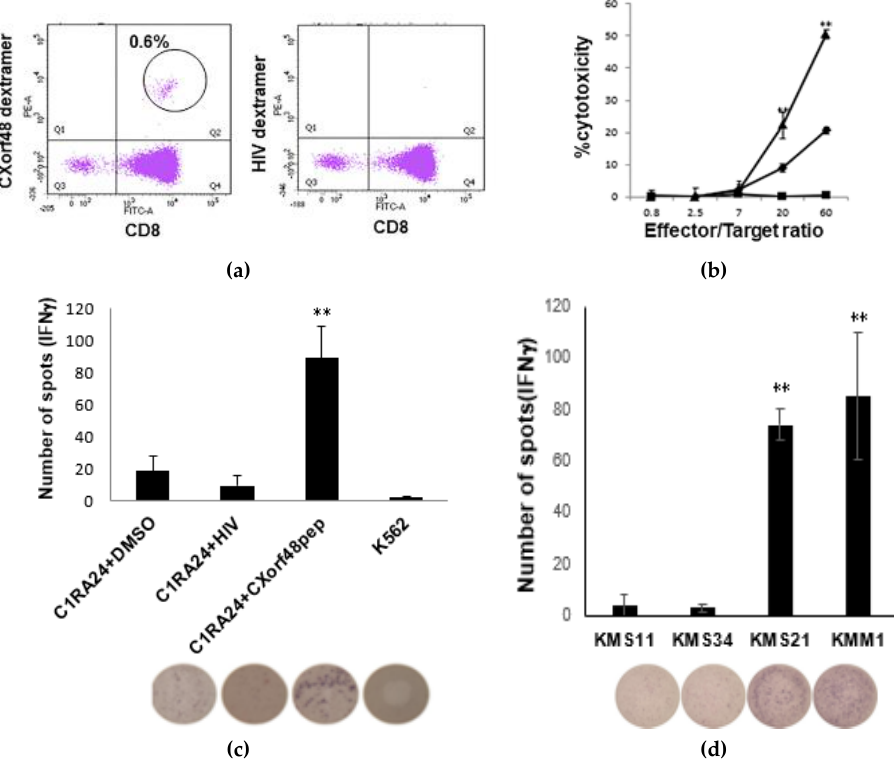
Figure 3. Activity of CXorf48-specific cytotoxic T lymphocytes (CTLs) against myeloma cells. ( a ) CXorf48-specific CTLs induced from peripheral blood mononuclear cells (PBMNC) from